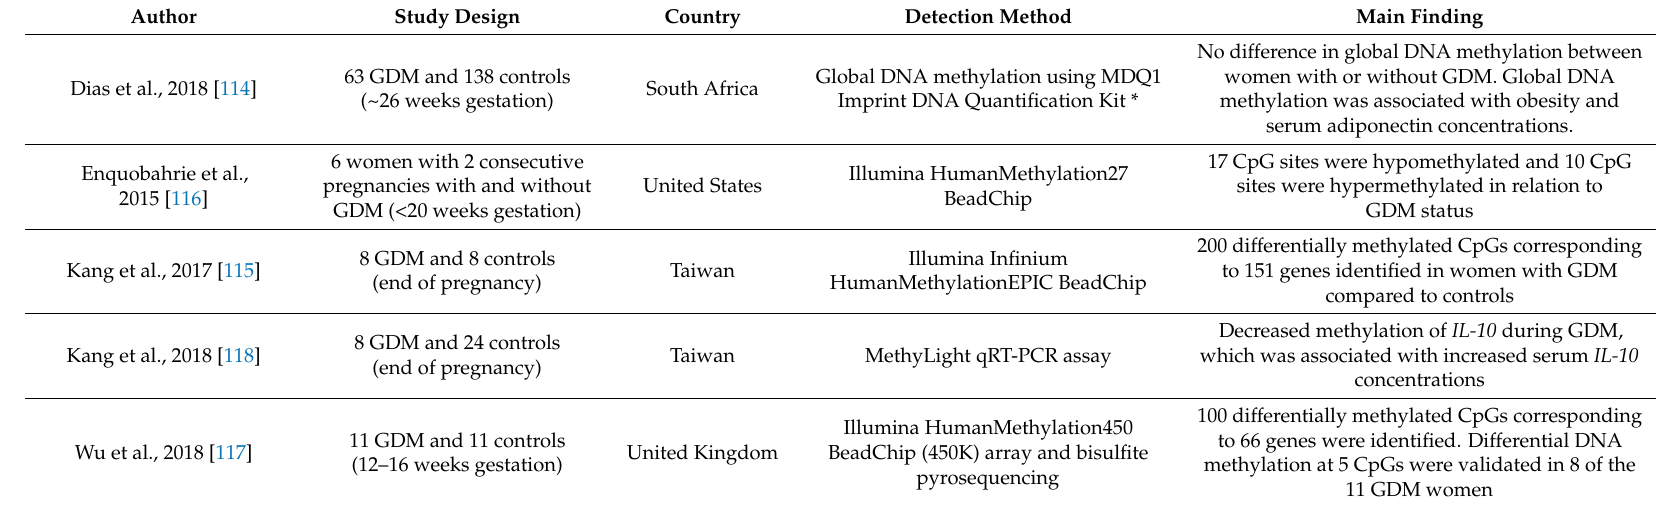
Table 2. Studies investigating DNA methylation in whole blood during gestational diabetes